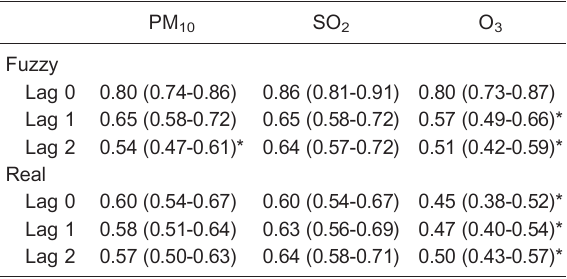
Table 3. Areas under the receiver operating characteristic (ROC) curves for air pollutants and real and fuzzy values, Sa˜ o Jose´ dos Campos, SP, Brazil,